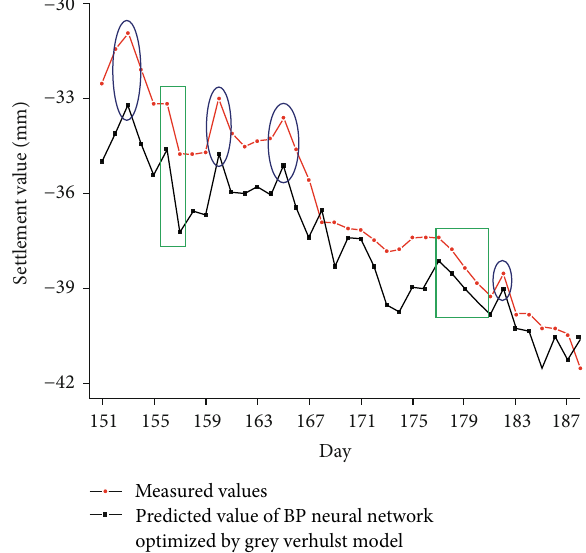
Figure 5: The comparison between measured values and predicted values of the BP neural network optimized by the grey Verhulst